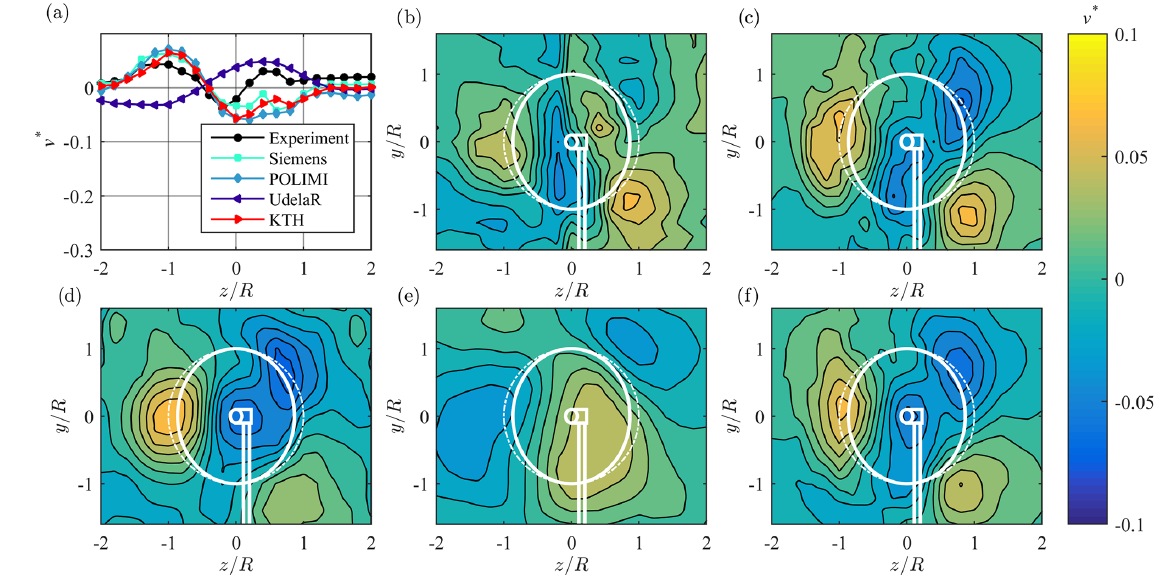
Figure 12. (a) Line plot at hub height and (b–f) contour plots for normalized vertical mean velocity v ∗ in the wake D behind downstream turbine T2, from (b) experiments, (c) Siemens, (d) POLIMI, (e) UdelaR, and (f) KTH. The white lines represent the turbine rotor, nacelle, and tower; solid lines γ = 30 ◦ ; dashed lines γ = 0 ◦